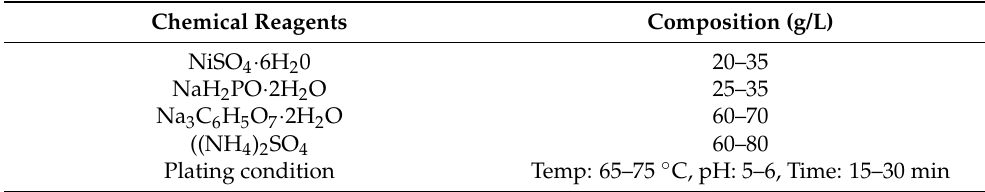
Table 2. Chemical plating bath composition and